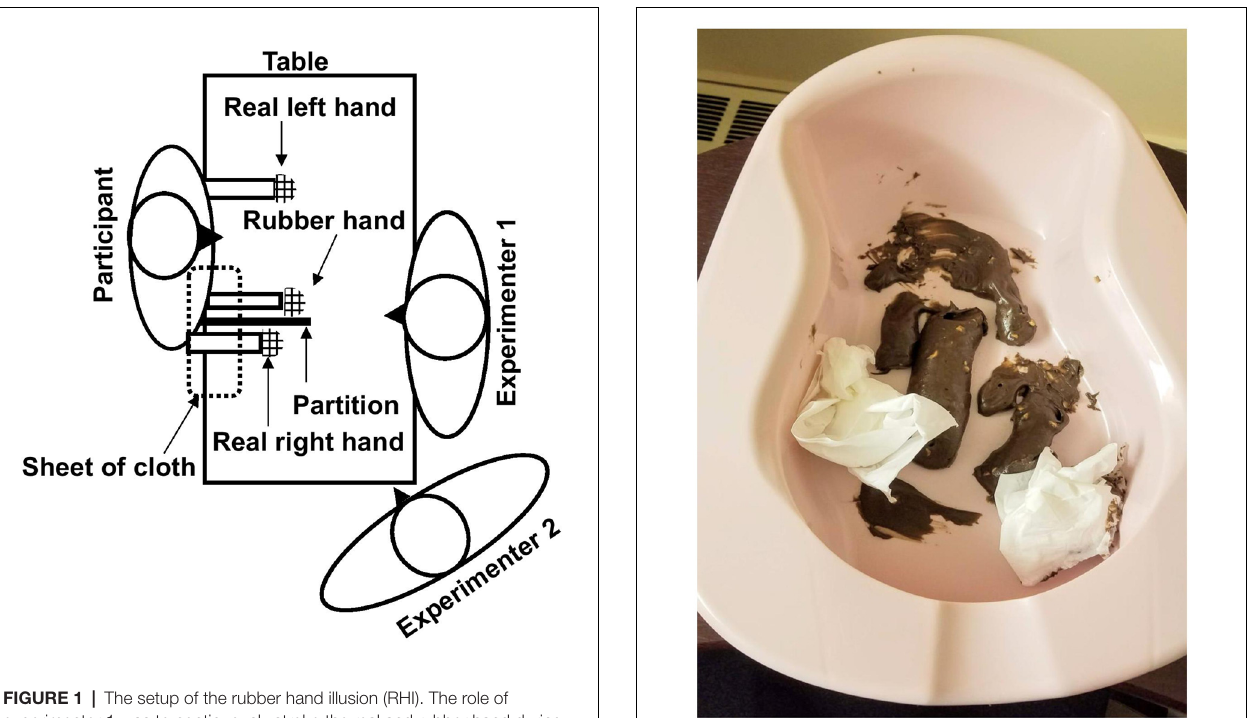
FIGURE 2 | Disgust